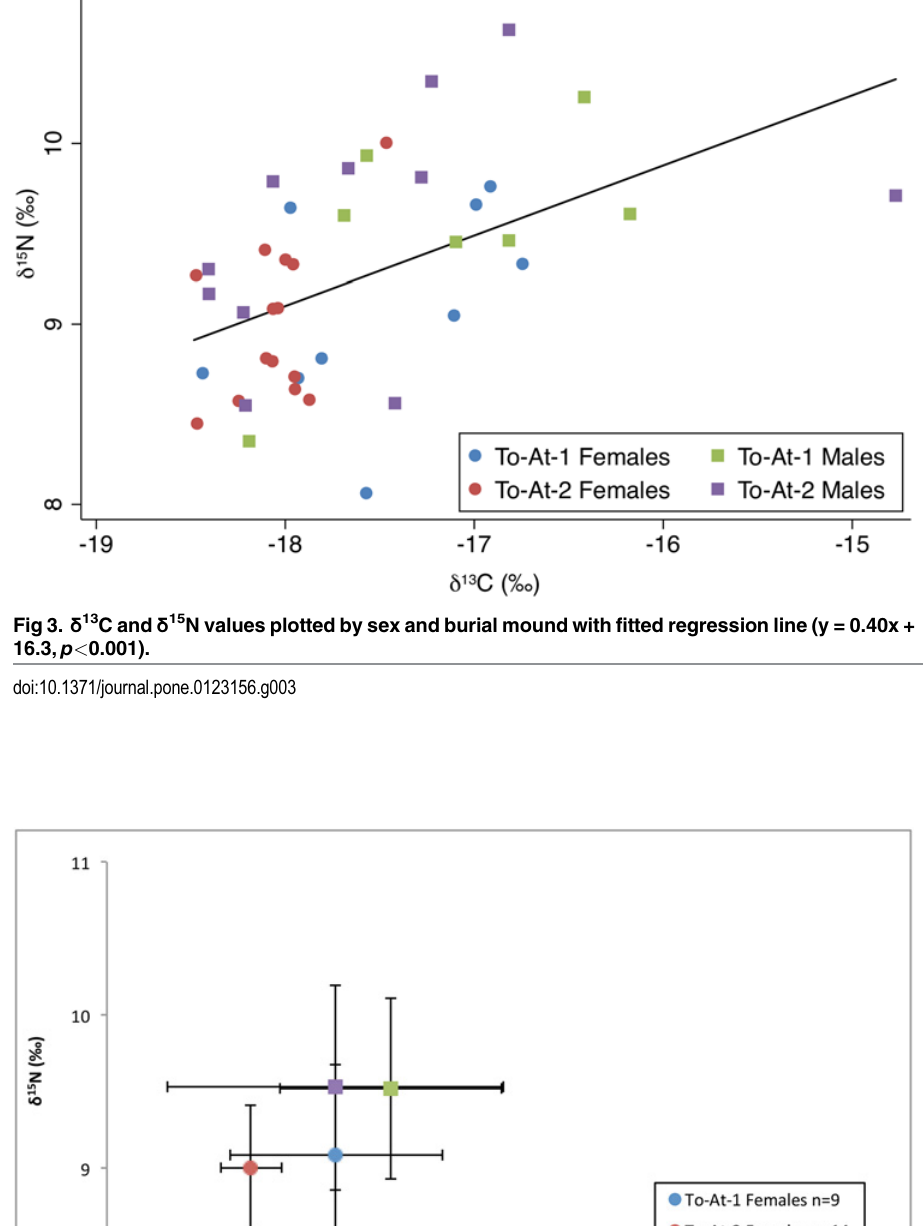
PLOS ONE | DOI:10.1371/journal.pone.0123156 March 30,